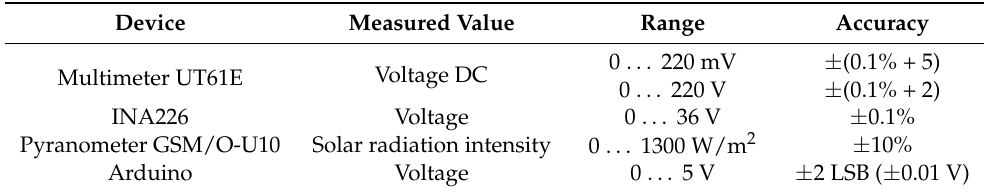
Table 2. Main metrological characteristics of the devices used.